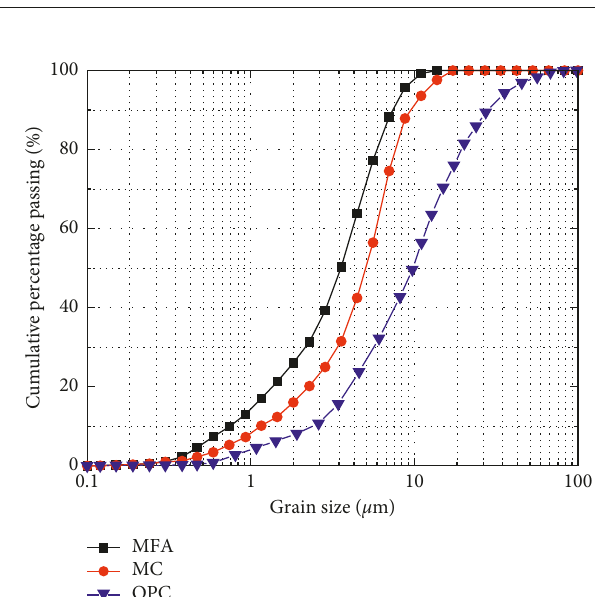
Figure 1: Grain size distributions of MC and